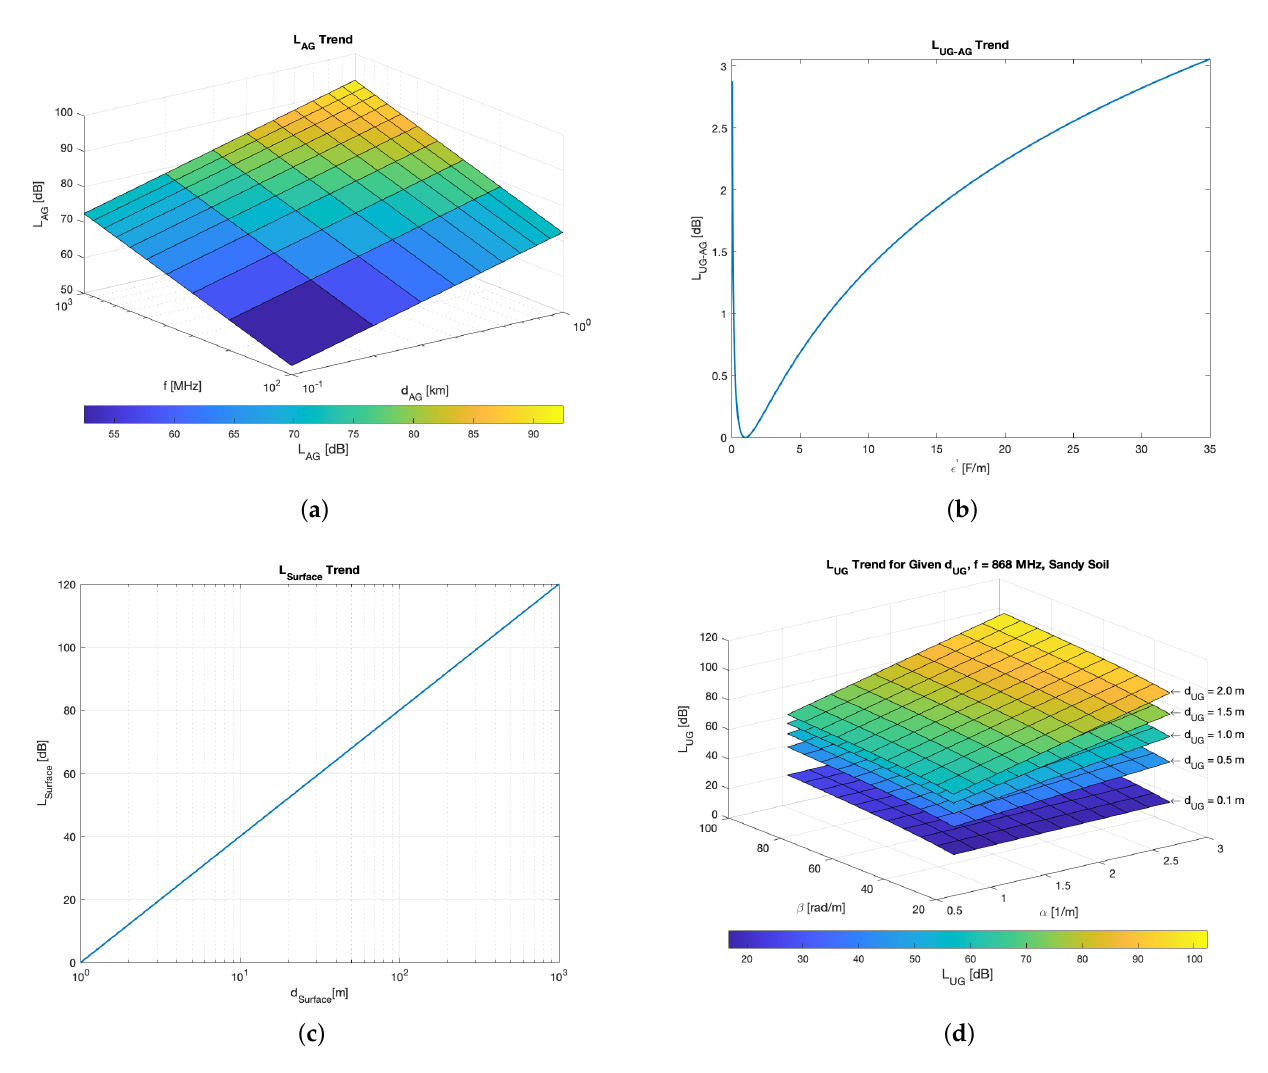
Figure 3. Trend in the losses which are involved in Equation (1): ( a ) L AG (Equation (2)), ( b ) L UG − AG (Equation (3)), ( c ) L Surface (Equation (4)), ( d ) L UG (Equation